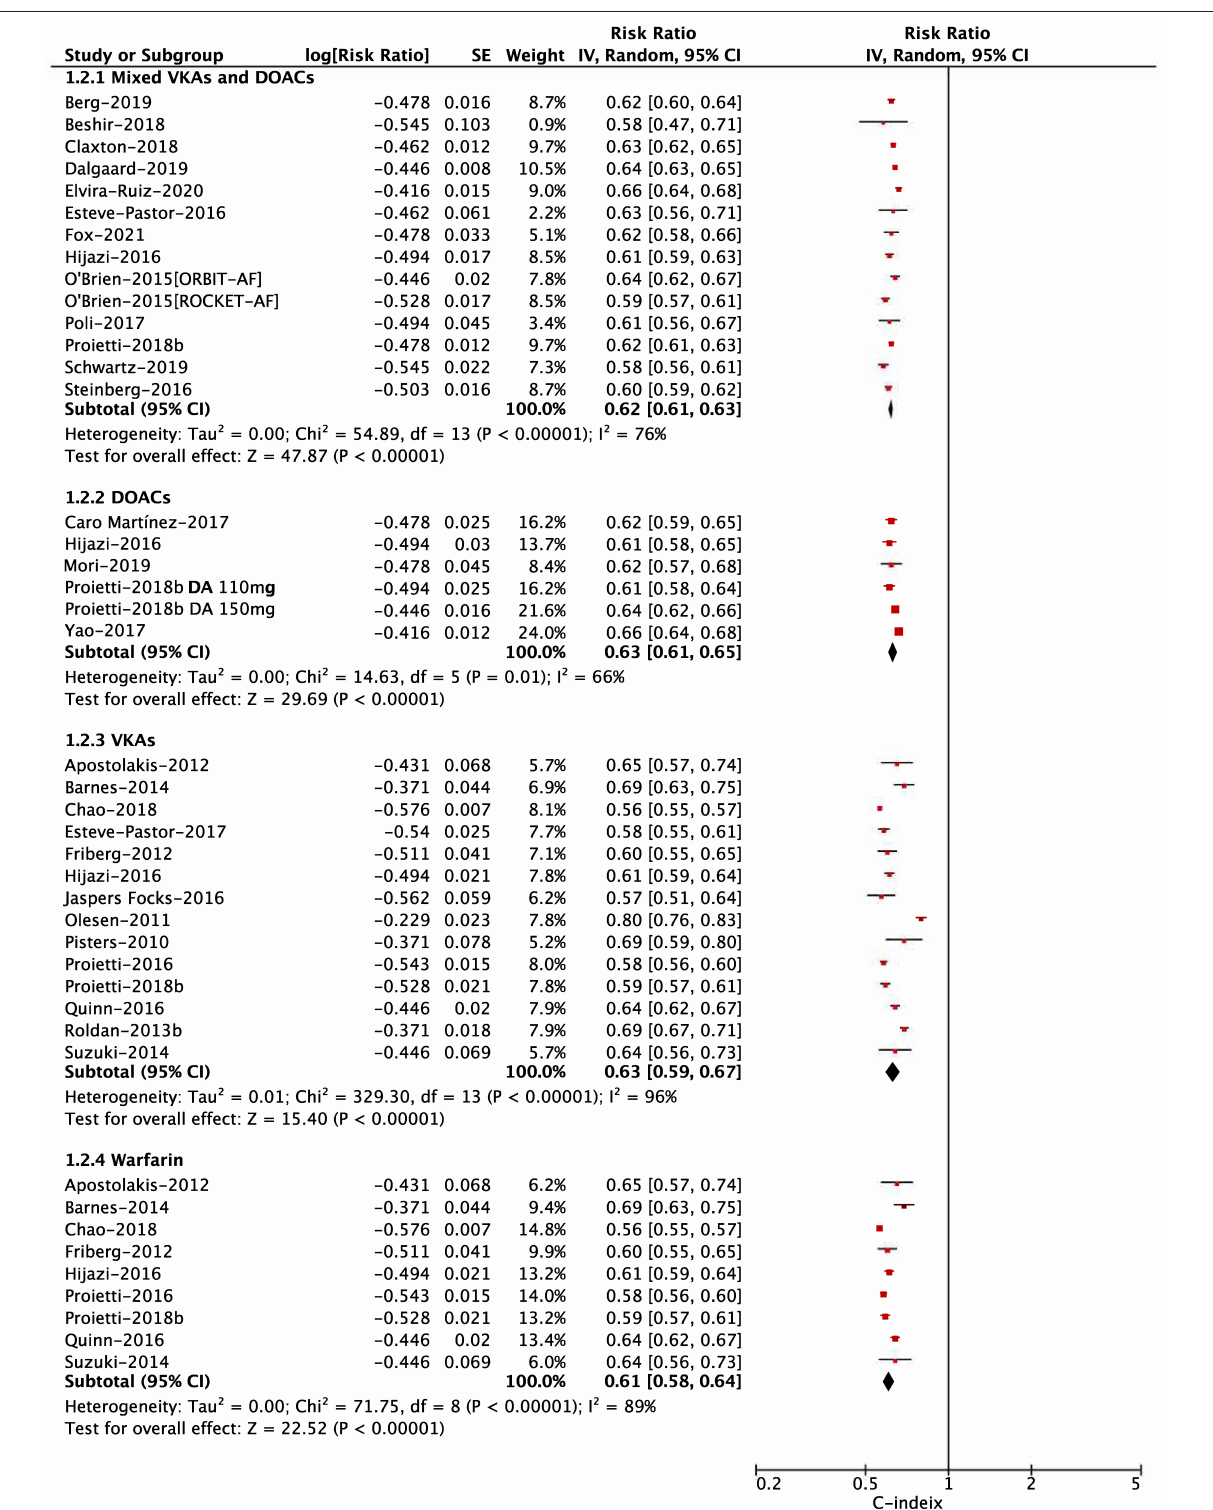
Frontiers in Cardiovascular Medicine |